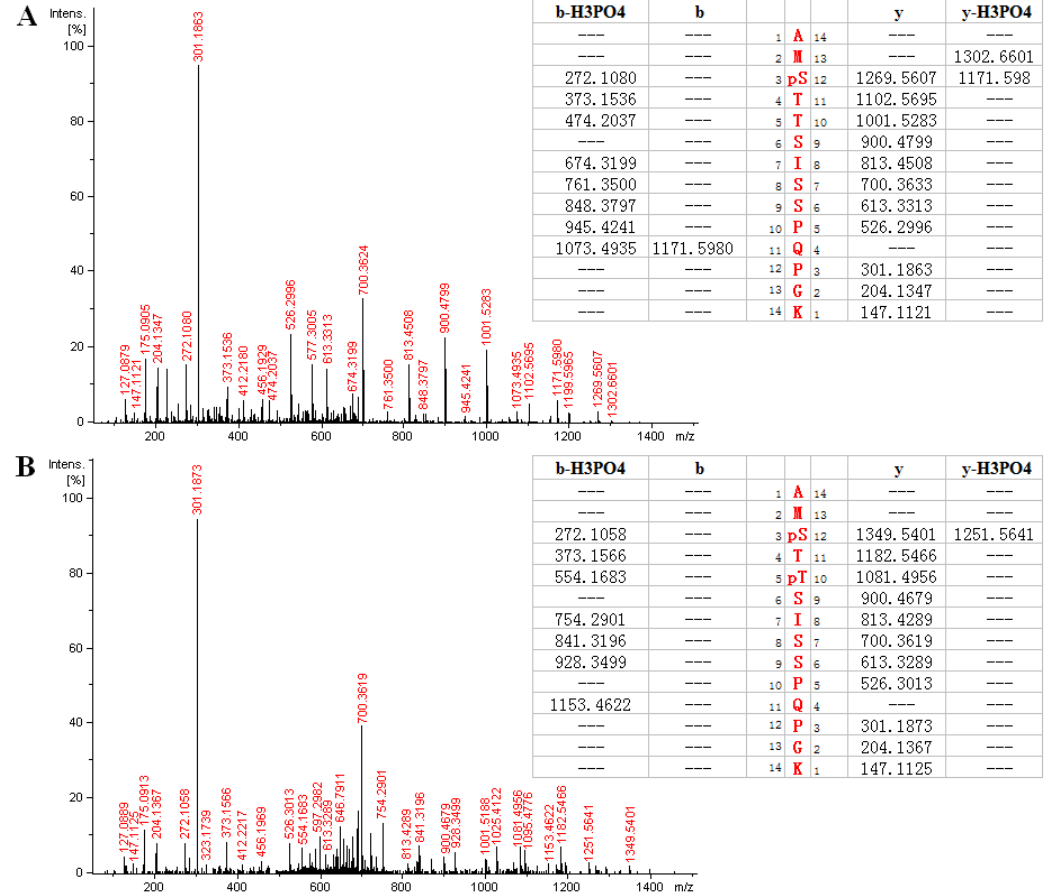
Figure 3. ( A ) MS/MS spectrum of a doubly-charged peak at m / z 736.333. The corresponding peptide is identified as AMpSTTSISSPQPGK (267–280), of which Serine 269 is phosphorylated; ( B ) MS/MS spectrum of a doubly-charged peak at m / z 776.318. The corresponding peptide is identified as AMpSTpTSISSPQPGK (267–280), of which both Serine 269 and Threonine 271 are